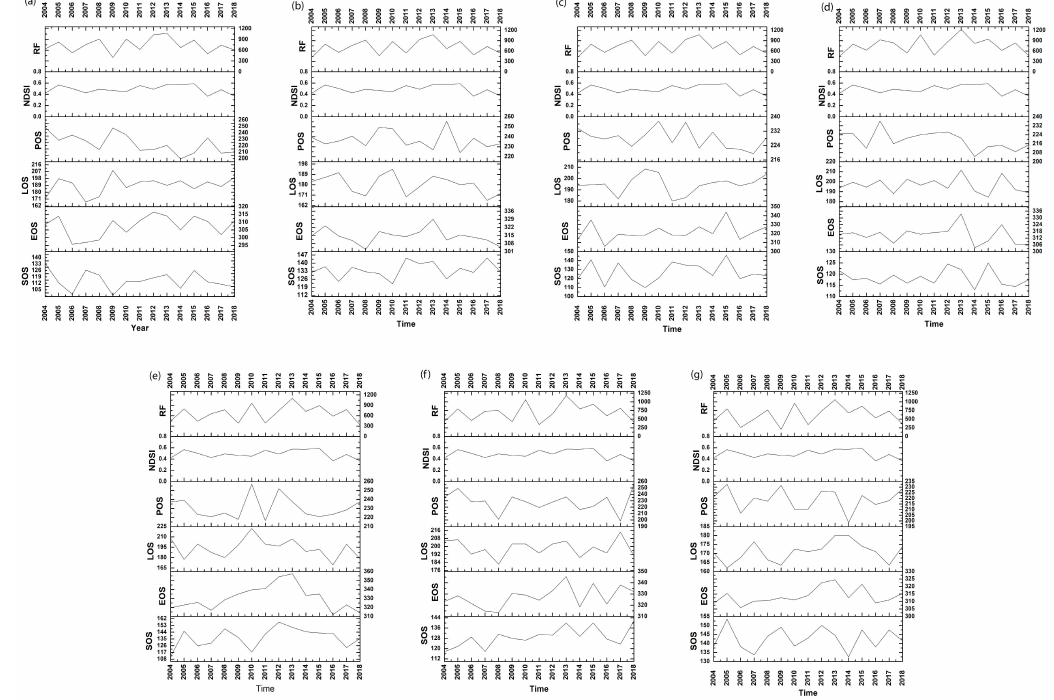
Figure 5. Graphs showing the variability of seasonality parameters, seasonal NDSI, and Rainfall in the selected apple orchard sites from 2004–2018: ( a ) KR1, ( b ) KR2, ( c ) KR3, ( d ) KR4, I KR-5, ( f ) KR6, and ( g )